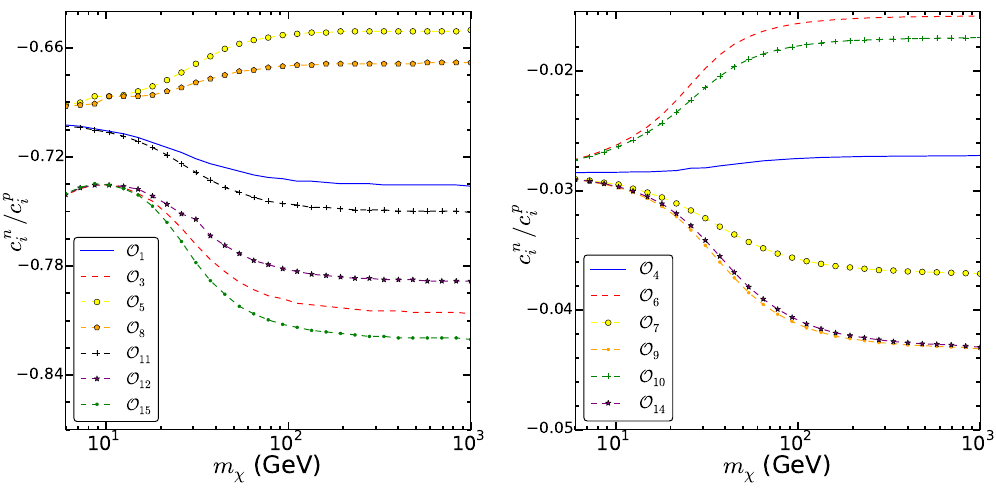
Figure 6 . The ratios the coe(cid:14)cients c n